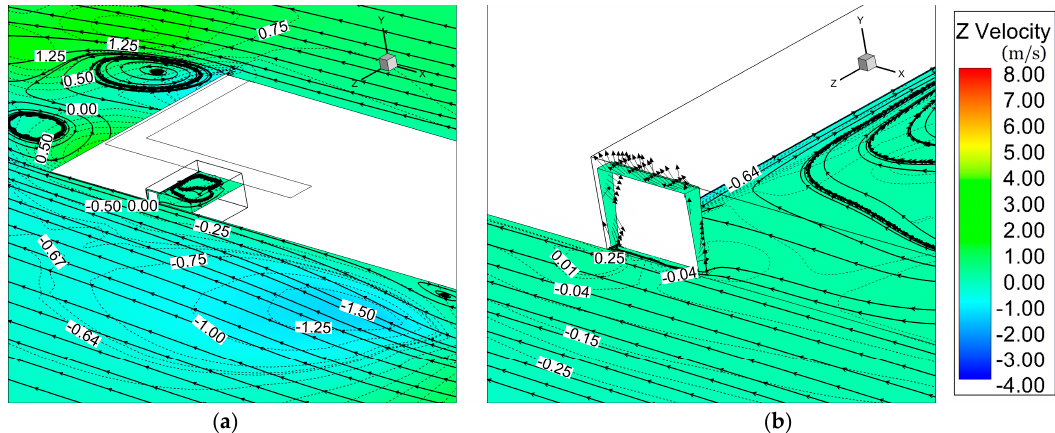
Figure 10. Flow patterns and contour of velocity (z-component), for 10 m / s wind speed and wind direction of 45 ◦ ( a ) around the building and ( b ) in front of the tilted window.